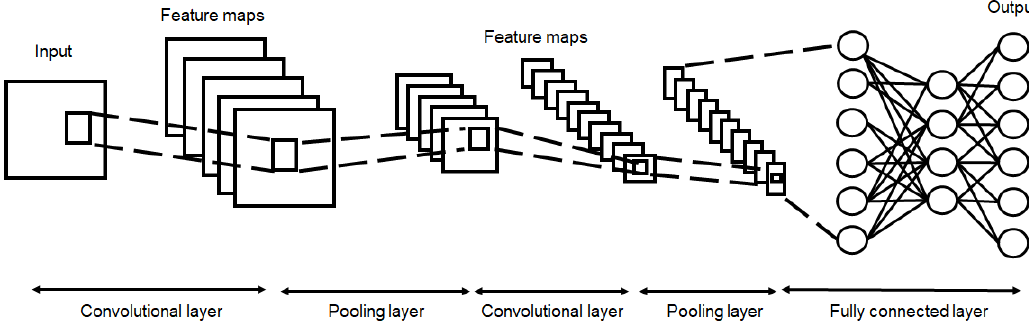
Figure 1. Architecture of the convolutional neural network (CNN)